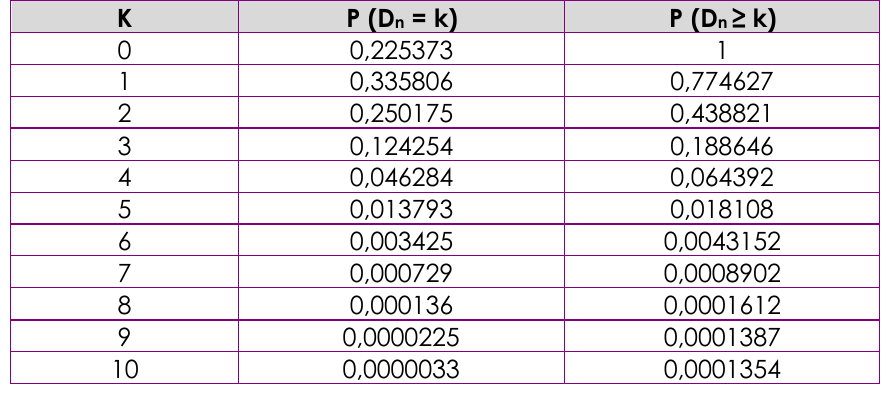
Table 3 Liner Demand